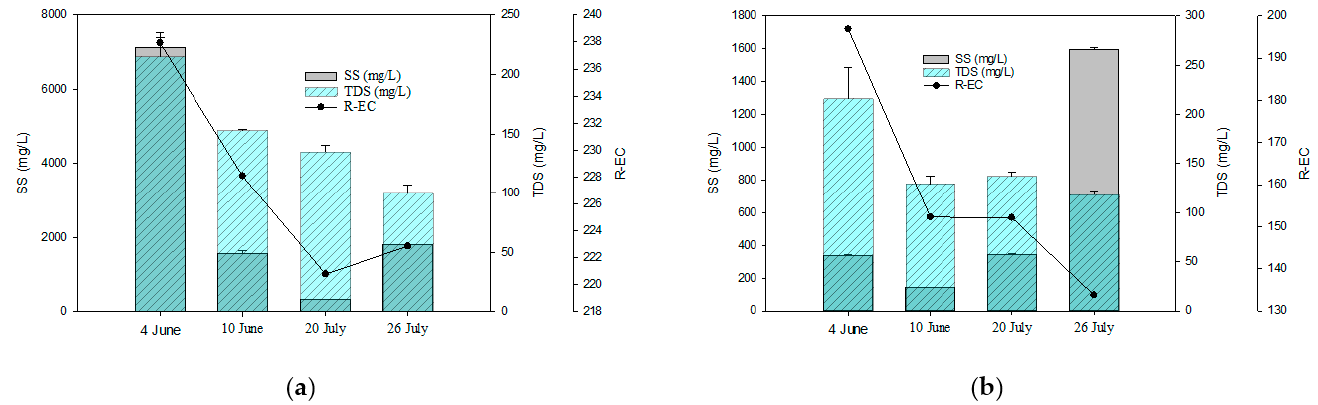
Figure 4. Changes in suspended solids (SS), total dissolved solids (TDS), and R-EC at depths of ( a ) 4.5 m and ( b ) 2.0 m.